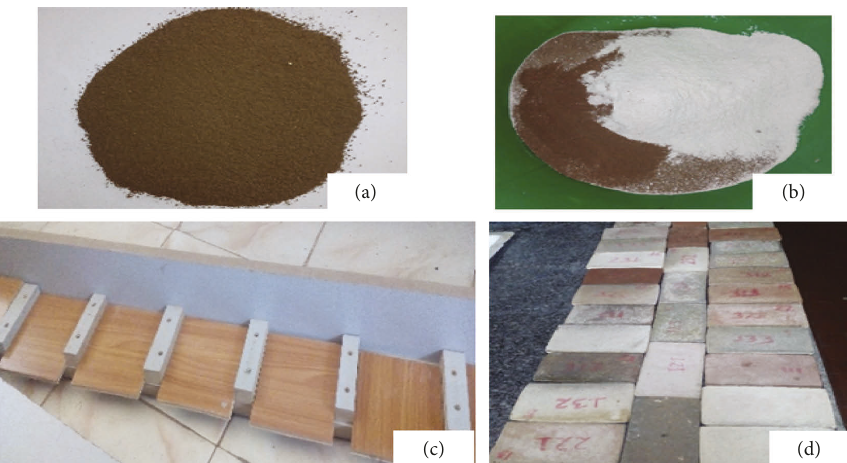
Figure 1: Manufacturing of ceramic materials: (a) clay, (b) mixture of clay and β -wollastonite, (c) formwork (mold), and (d) ceramic